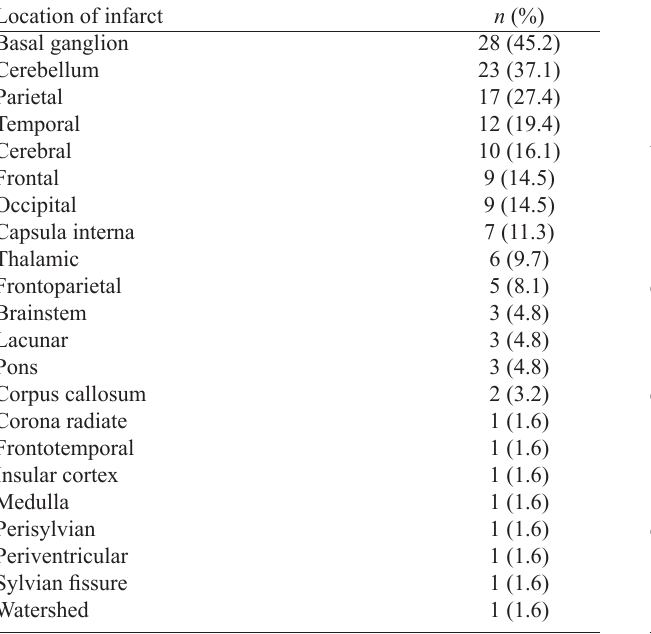
Table 6. Locations of cerebral infarcts in 62 patients.